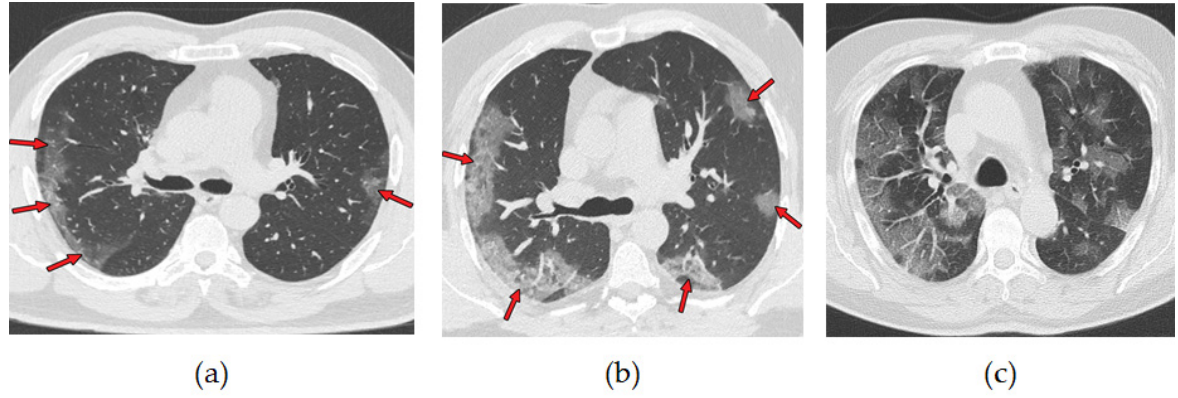
Figure 2. Axial nonenhanced chest CT images (lung window) in a 59-year-old man ( a ) and a 47- year-old man ( b ) show bilateral areas of ground-glass opacities (arrows) in a peripheral distribution; ( c ) shows bilateral ground-glass opacities and dilated segmental and subsegmental vessels, mainly on the right, in a 70-year-old man, each with positive RT-PCR test results for SARS-CoV-2. Adapted from [10].